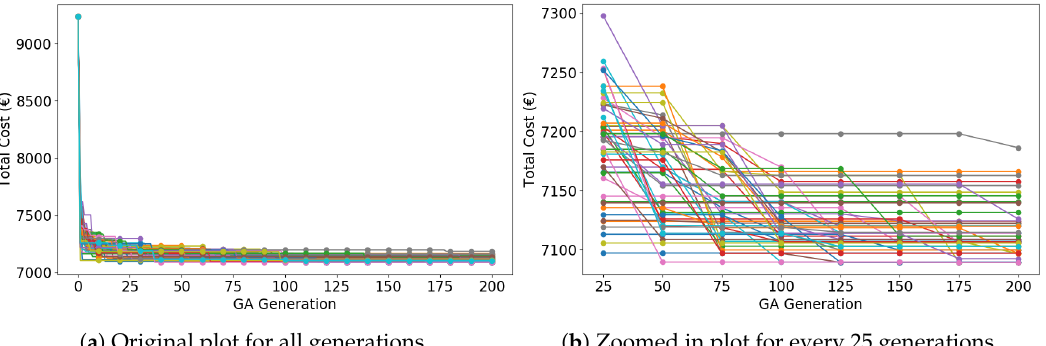
Figure 8. Total cost as a function of conventional genetic algorithm (CGA) generations (50 curves of 50 simulations).